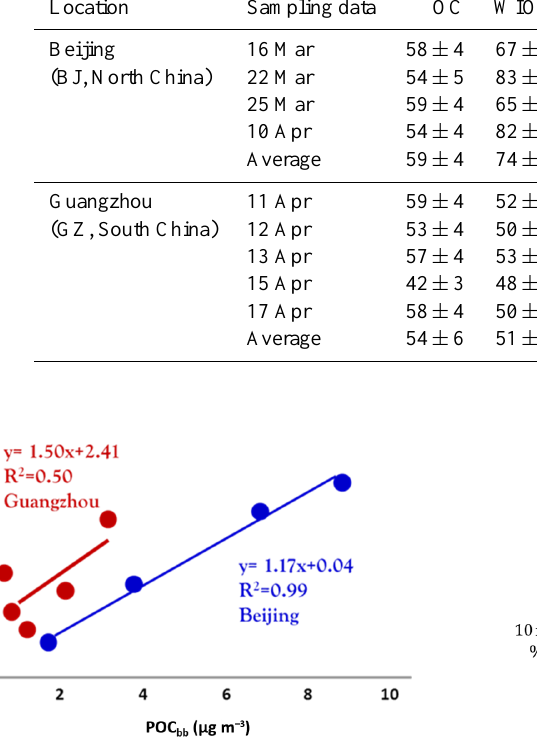
Table 2. Percentages of non-fossil sources in various carbon species (%). Location Sampling data